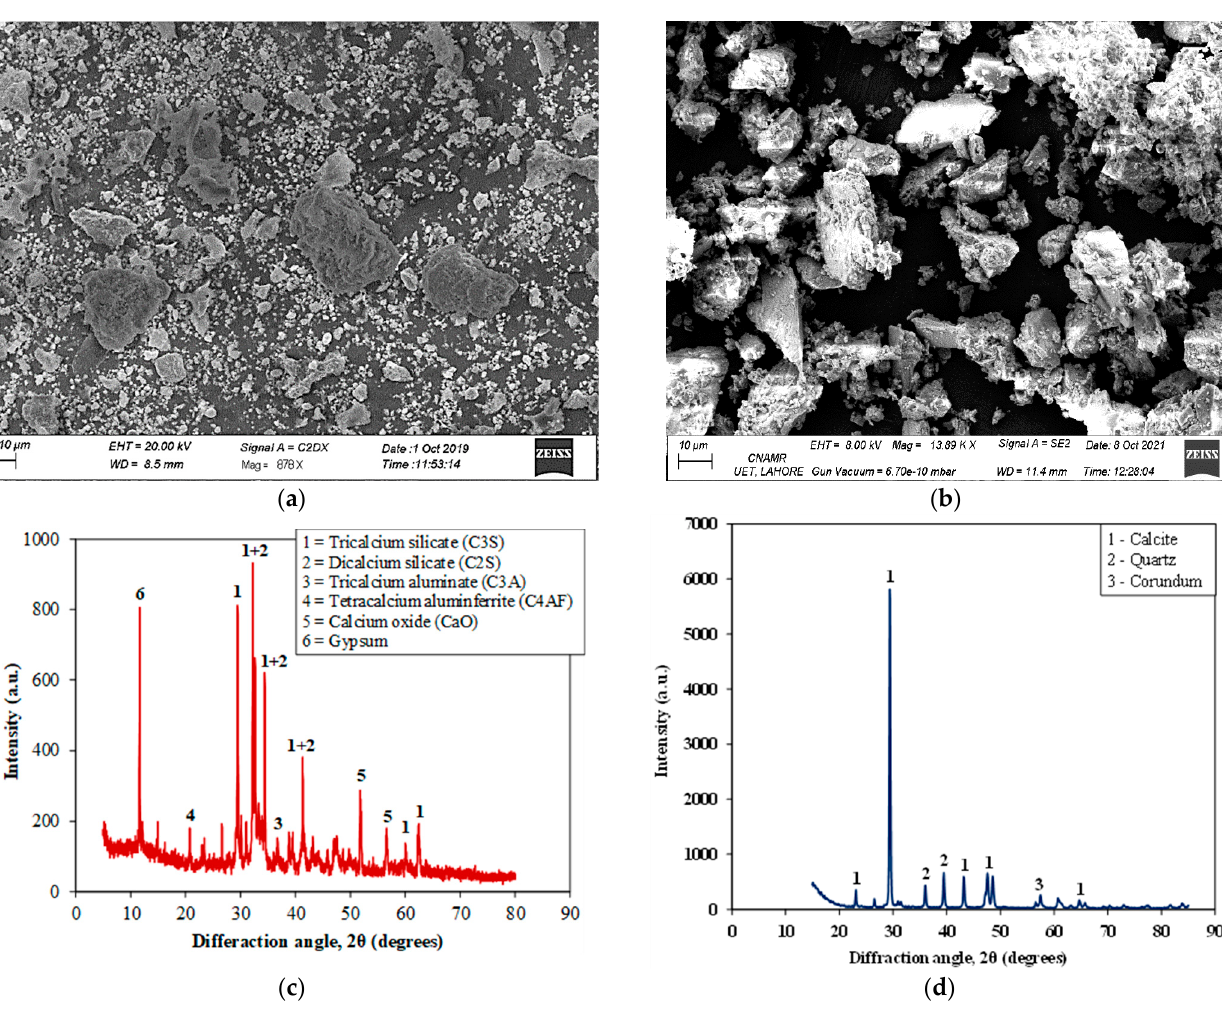
Figure 2. SEM and XRD patterns of raw materials ( a ) SEM image of cement ( b ) SEM image of MS ( c ) XRD pattern of cement ( d ) XRD pattern of MS. Table 3. Physical properties of raw materials (cement and